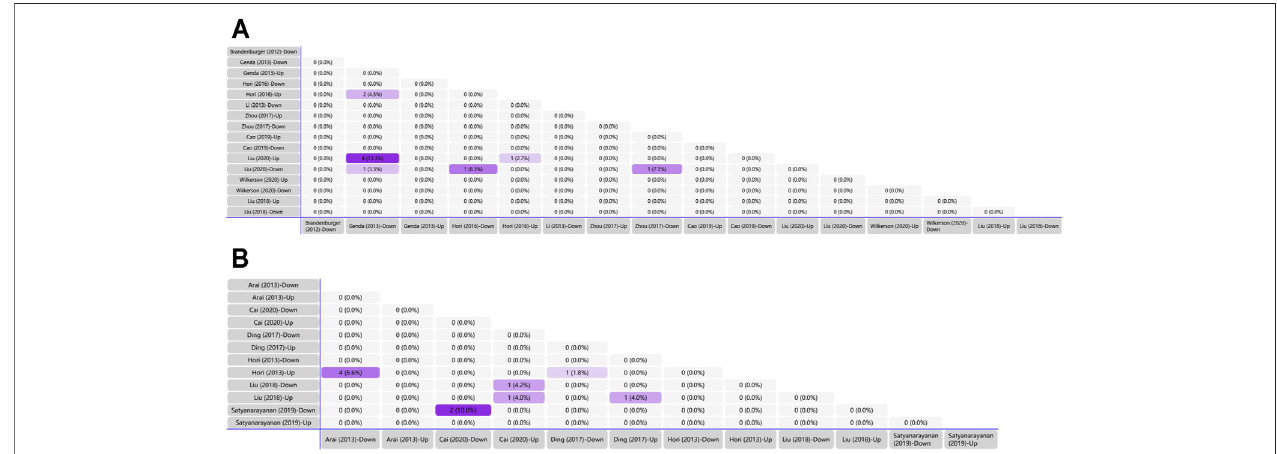
FIGURE 2 | Tabular Venn diagram analysis. (A) Matrix table analysis for miRNAs expression pro fi les in spinal cord of NP surgical models. The number and percentage of co-regulated miRNAs were highlighted. Overlapping miRNAs: 2 (4.3%): miR-21, miR-27b; 4 (13.3%): miR-22, miR-377, miR-7a, miR-21; 1 (3.3%): miR- 365; 1 (8.3%): miR-214; 1 (2.7%): miR-21; 1 (7.1%): miR-184. (B) Matrix table analysis for miRNAs expression pro fi les in brain of NP surgical models. The number and percentage of co-regulated miRNAs were highlighted. Overlapping miRNAs: 4 (6.6%): miR-132, miR-151-3p, miR-186, miR-204; 2 (10.0%): miR-200b-3p, miR-